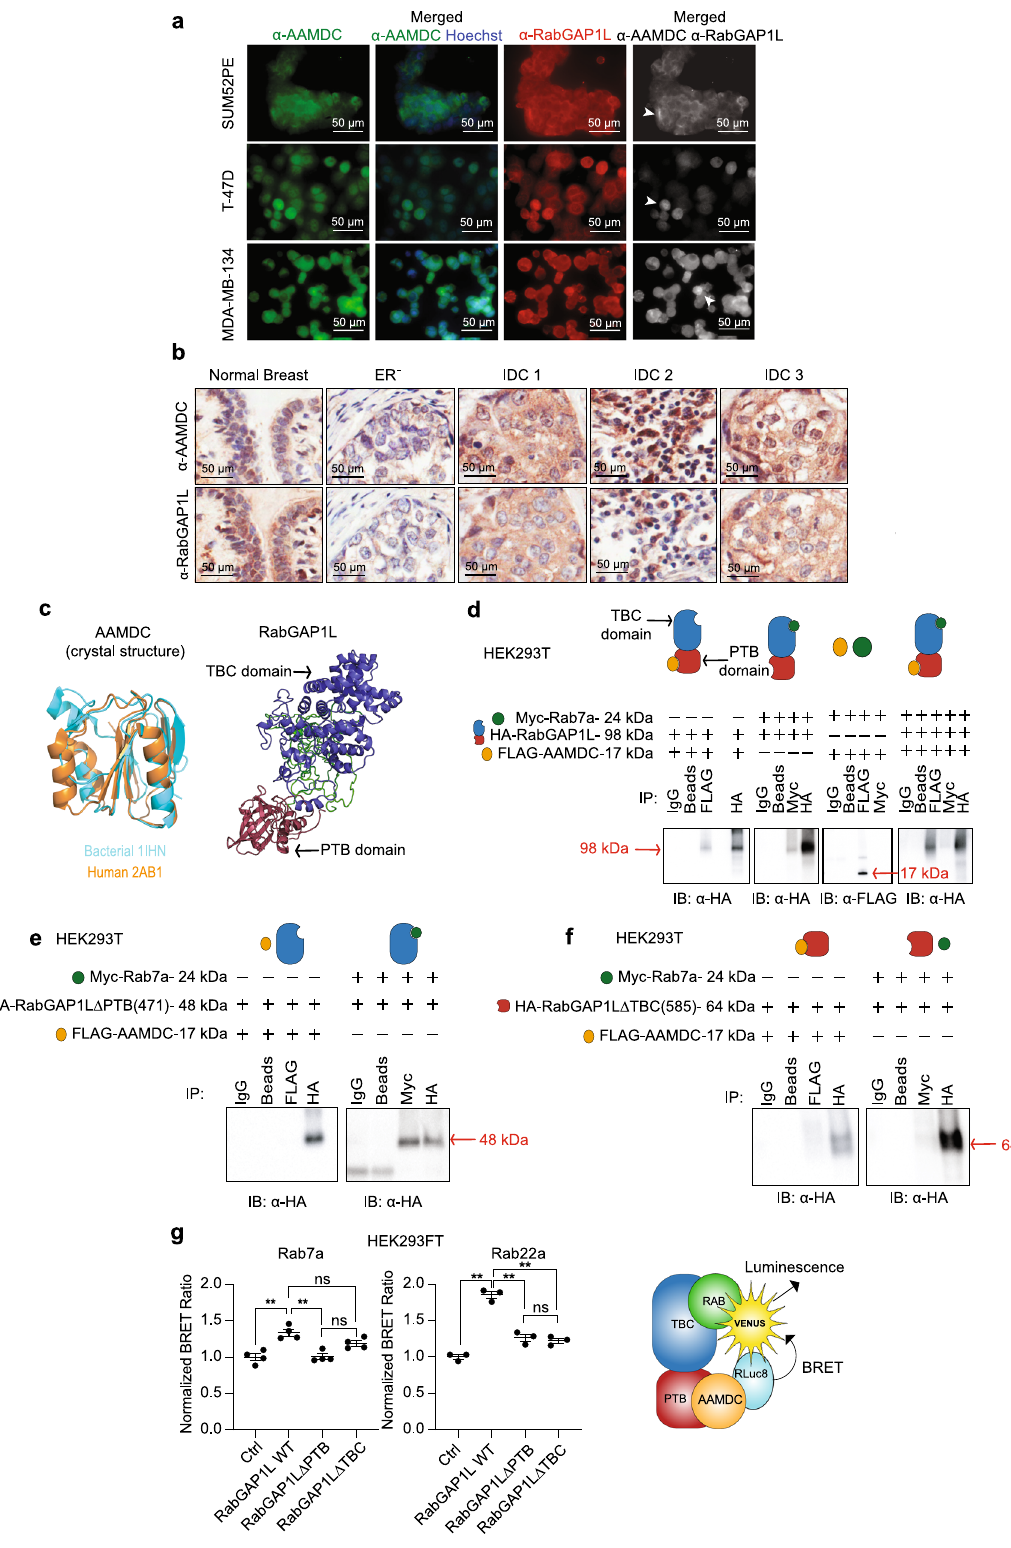
with either empty vector (pLKO.1) or AAMDC sh2. The cells were seeded over- night in 13mm glass coverslips pre-treated with poly-L-lysine (Sigma-Aldrich). Subsequently, the cells were fi xed with 4% paraformaldehyde, blocked with 5% normal goat serum, and incubated overnight at 4 °C with the primary antibodies α